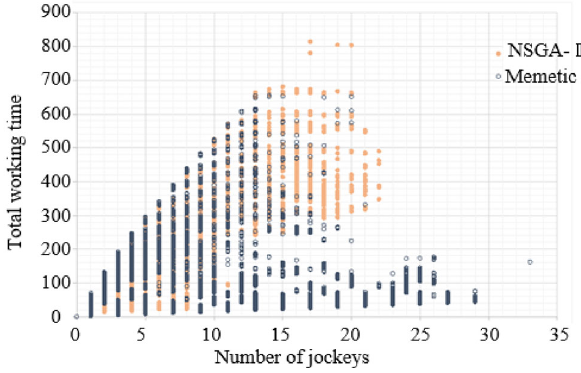
Fig. 10 Hypervolume indicator